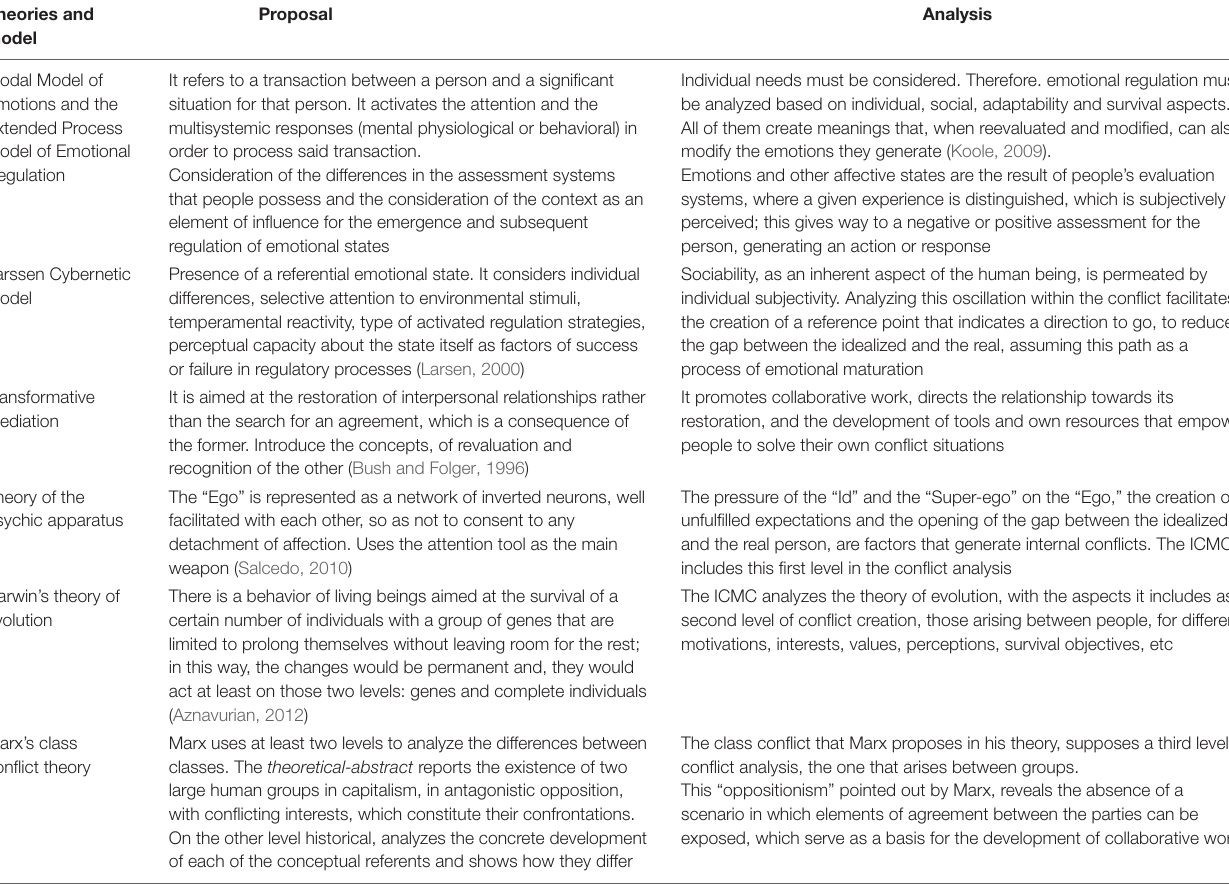
TABLE 1 | Conceptual summary of the Integrated Circular Model of Conflict Theories, models and previous studies. Theories and